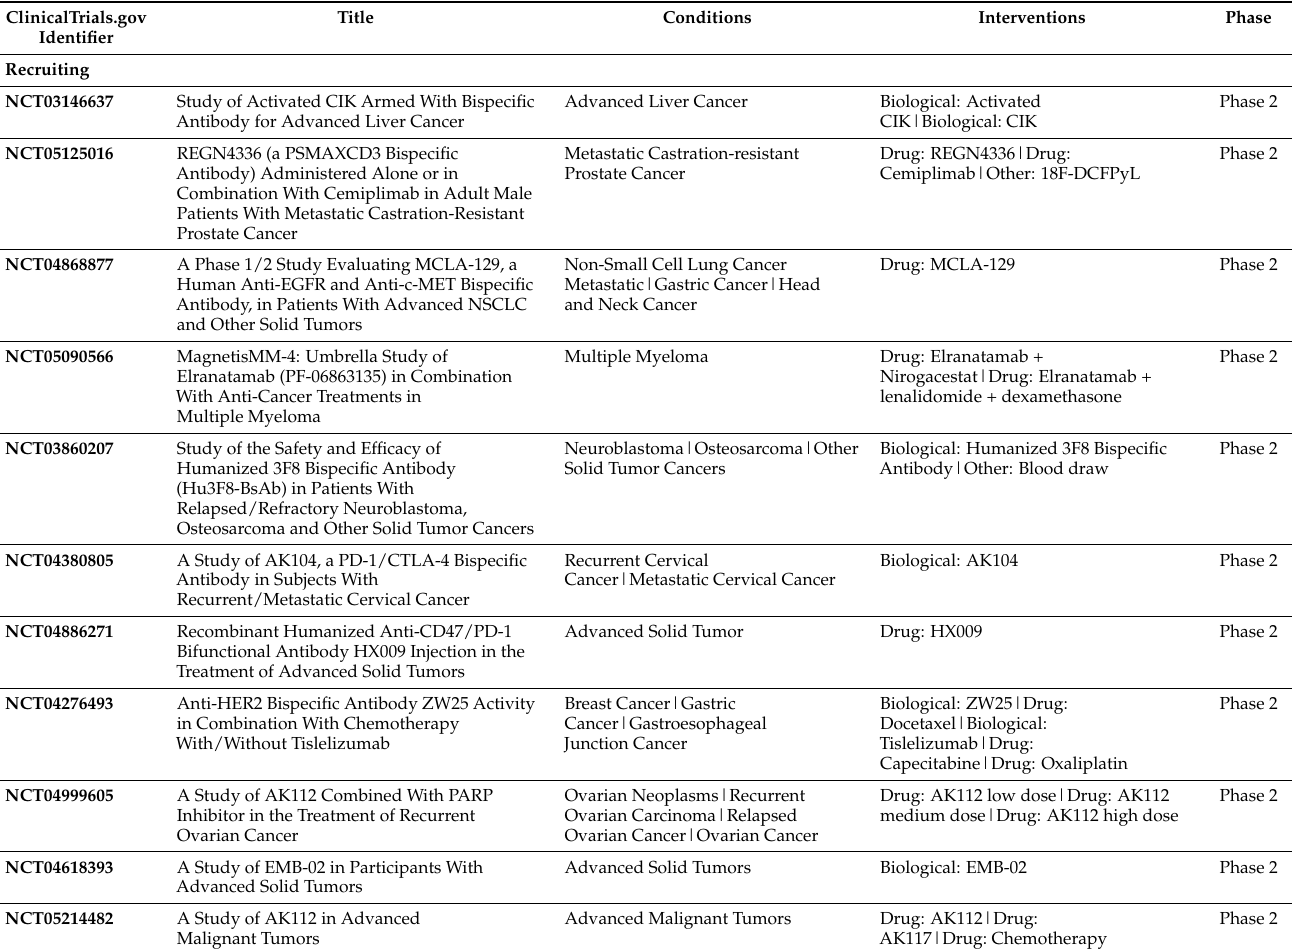
Table 1. Some of the clinical trials of different molecules that remain under evaluation for use, we present the code of the trial (ClinicalTrials.gov accessed on 16 March 2022), the name of the trial, the type of cancer-related to the molecule, and the current phase of the